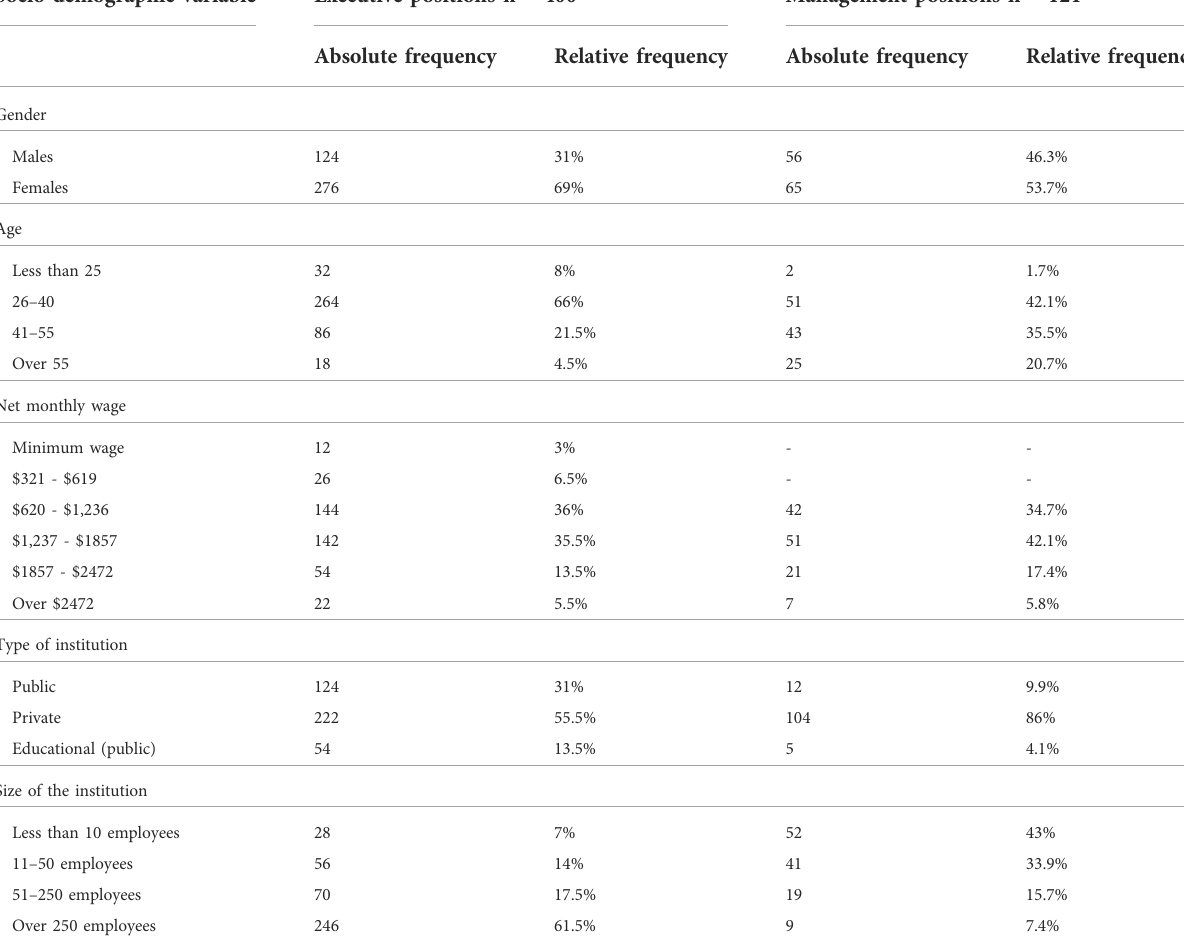
TABLE 1 The structure of the two